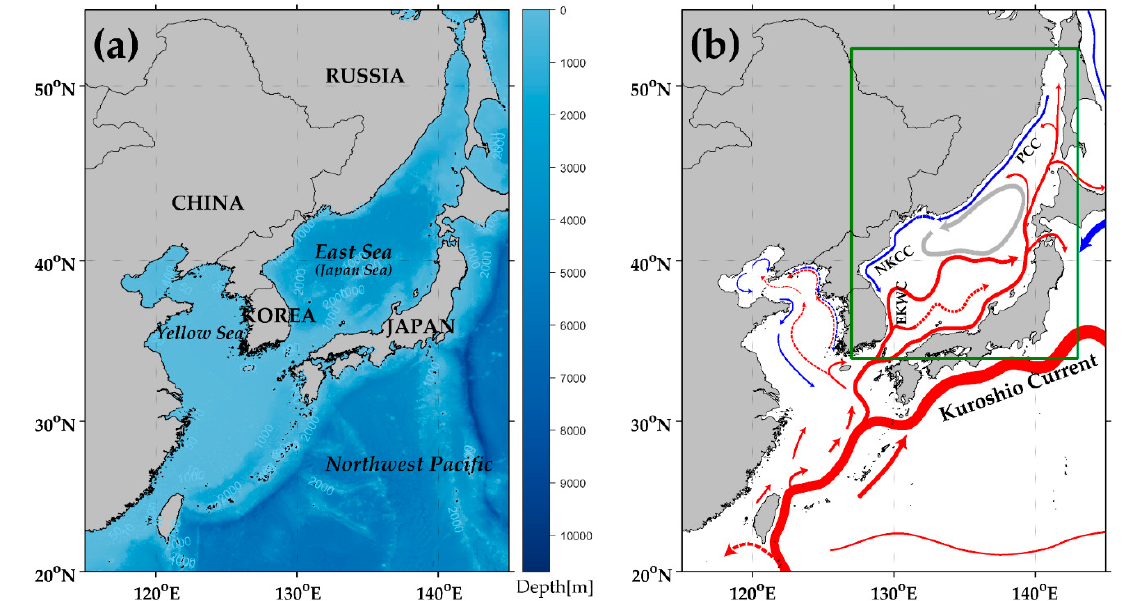
Figure 1. ( a ) Bathymetry of the seas around Korean peninsula; and ( b ) a schematic current map with cold (blue) and warm (red) currents (EKWC: East Korea Warm Current, NKCC: North Korea Cold Current, PCC: Primorye Cold Current) (adapted from [17]), where the line width represents the overall strength of the current and the green box shows the study area.